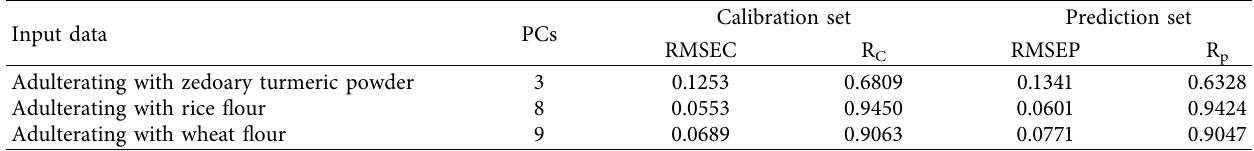
Table 3: The results of